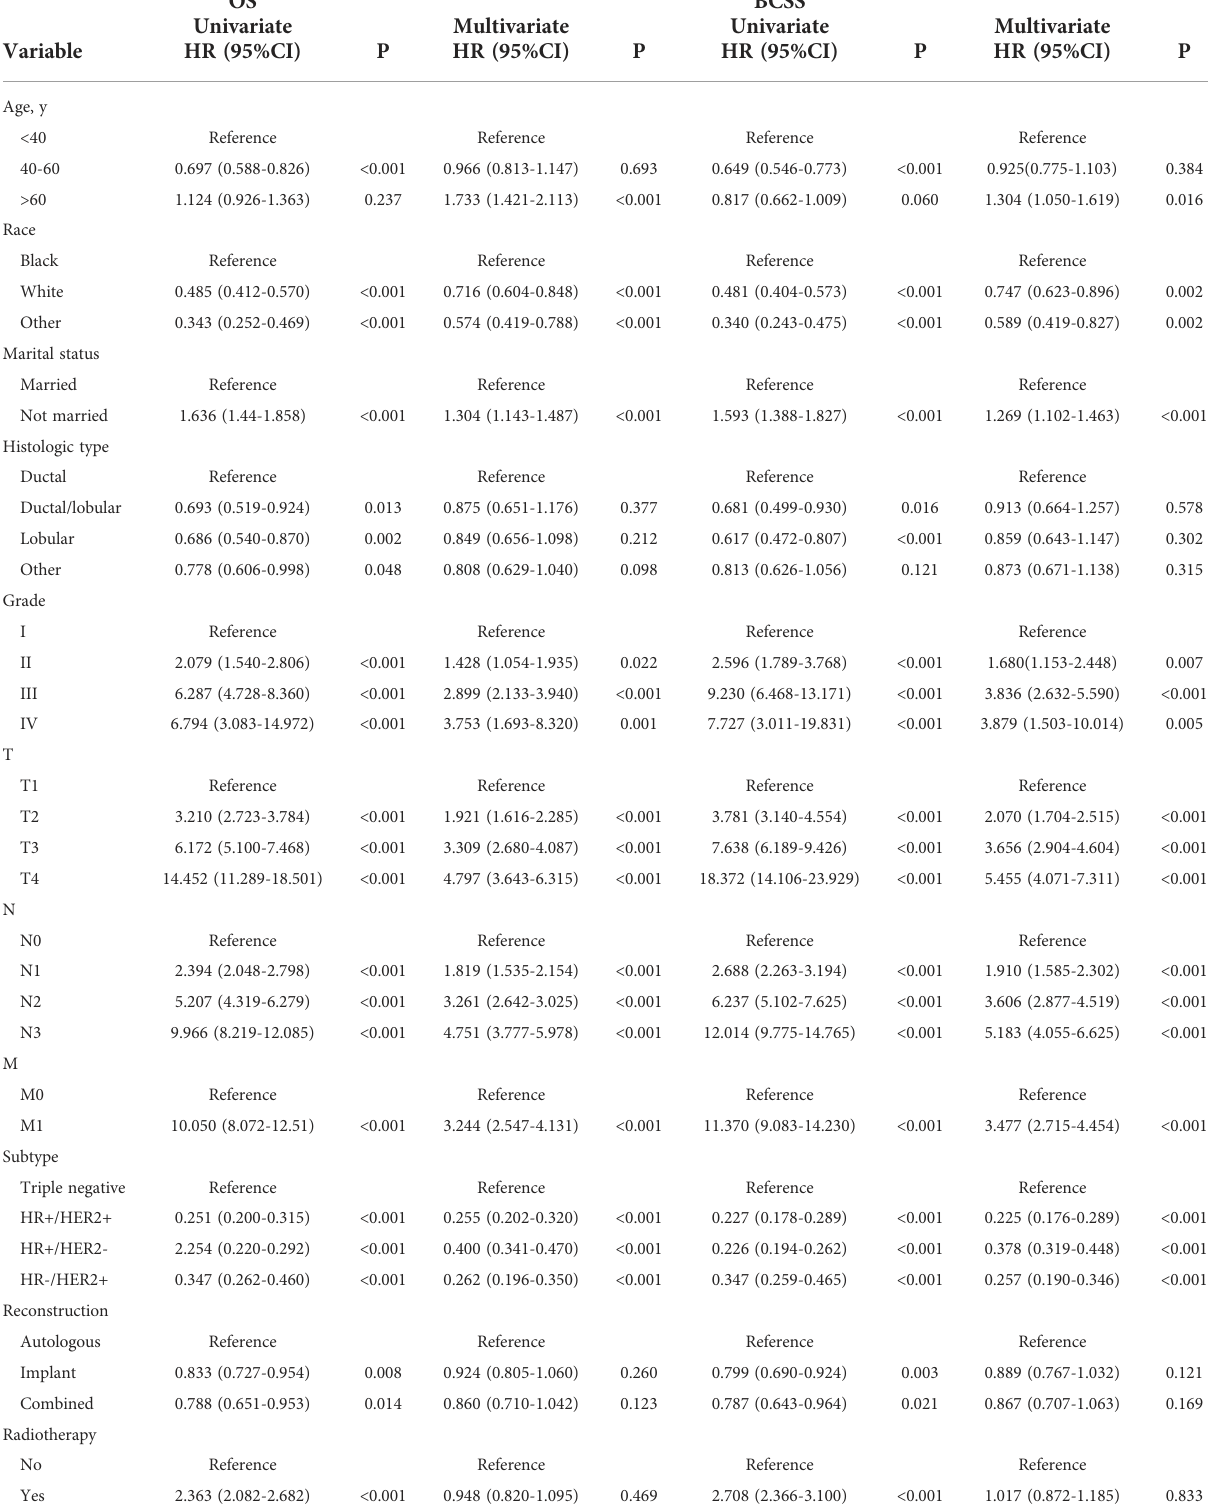
TABLE 3 OS and BCSS in univariate and multivariate analyses. OS BCSS Univariate Multivariate Univariate